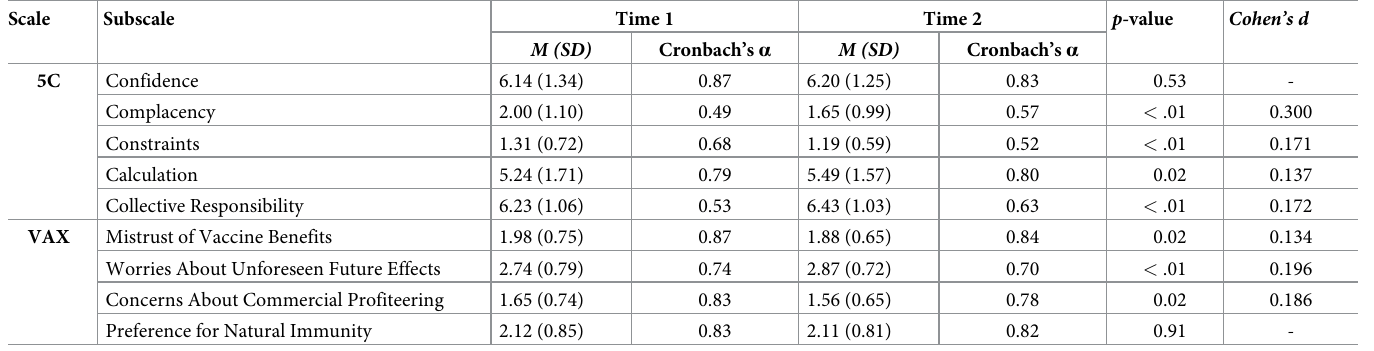
Table 2. Means and Cronbach’s alphas for 5C and VAX-measured vaccination attitudes over 12 months.